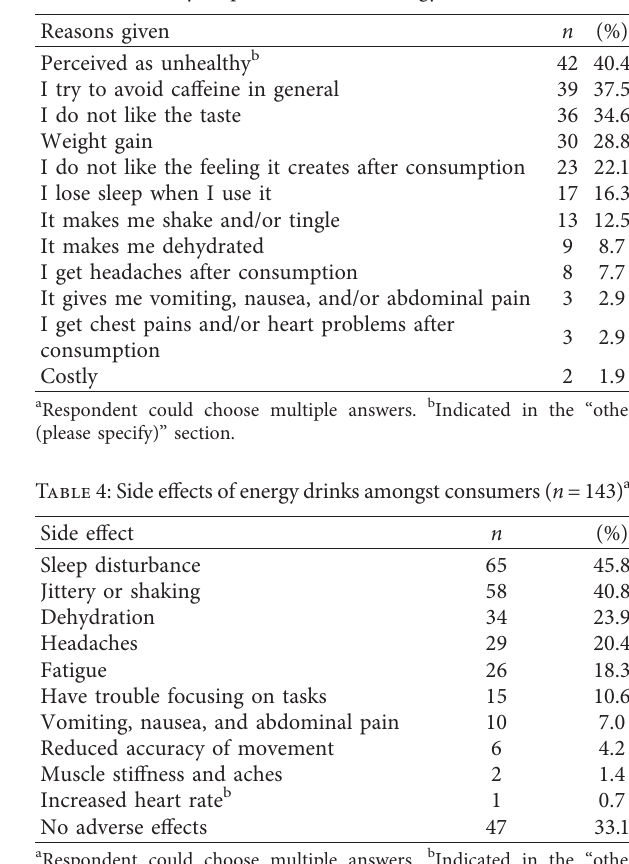
Table 3: Why respondents avoid energy drinks ( n � 104) a .